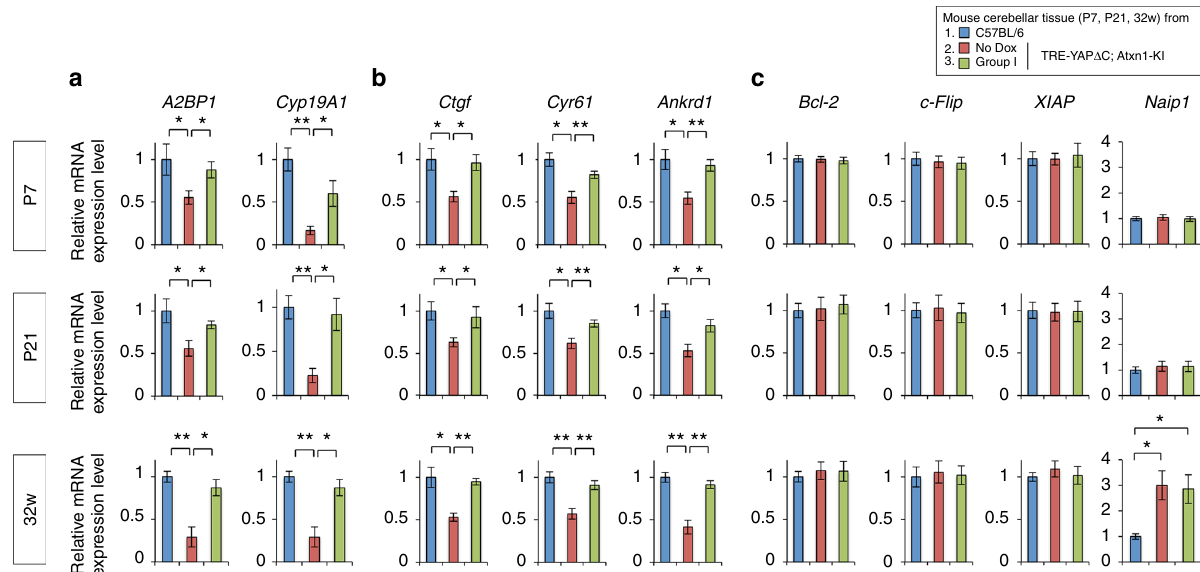
Fig. 10 YAPdeltaC restores ROR α target gene expression in Group I mice in vivo. a RT-qPCR con fi rmed that YAPdeltaC overexpression in Group I mice rescued the reduced expression of two ROR α target genes ( A2bp1 and Cyp19a1 ) in Purkinje cells of Atxn1 -KI mice at P7, P21, and 32 weeks. b RT-qPCR revealed a similar change in YAP target genes independent of ROR α : Cyp19a1 (TEAD-dependent 26, 27 ), Cyr61 (TEAD-dependent 26, 27 ), and Ankrd1 (TEAD-dependent 26, 27 ). c RT-qPCR detected no remarkable changes in expression of representative anti-apoptotic genes (Bcl-2, c-Flip, XIAP, Naip1) in Purkinje cells in three types of mice. Single and double asterisks indicate statistical signi fi cance ( p < 0.05 and p < 0.01, N = 3) in one-way ANOVA